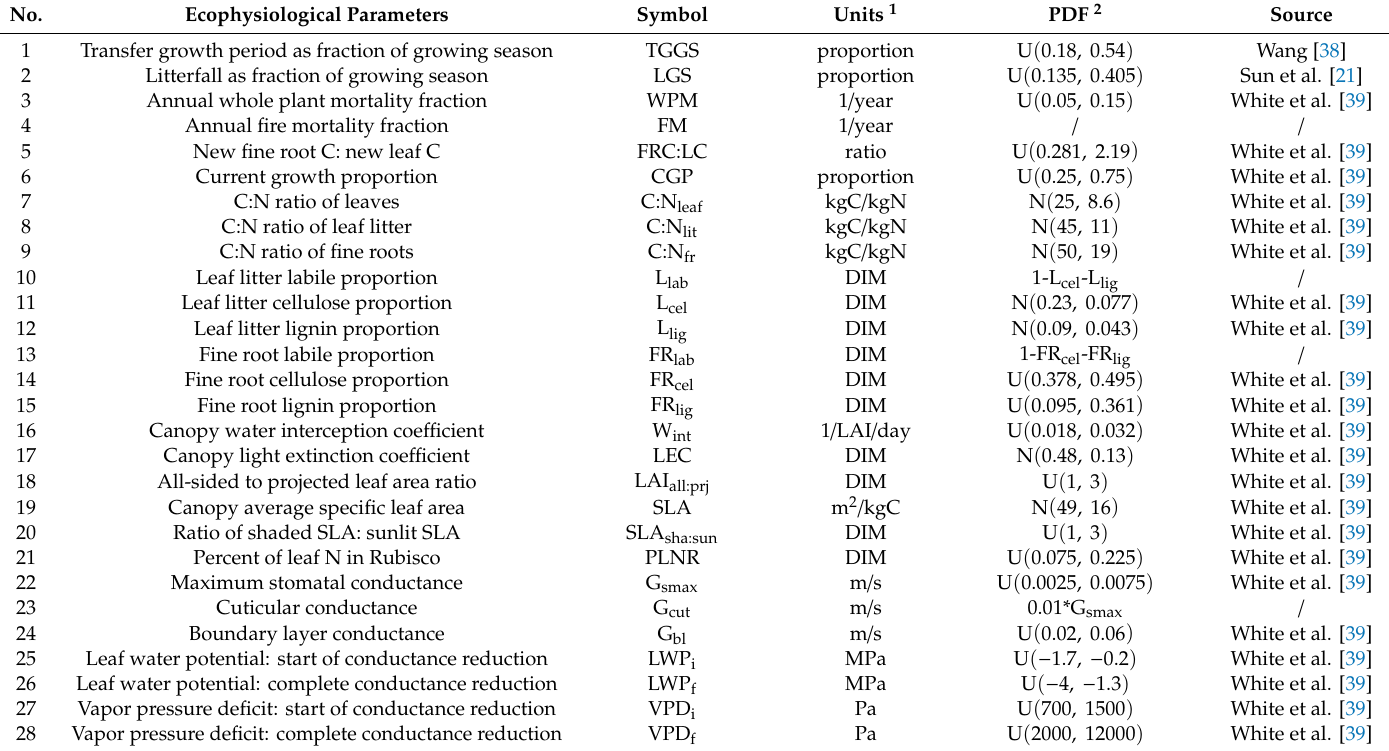
Table 1. Ecophysiological parameters of the Biome-BGC model for the type of C3